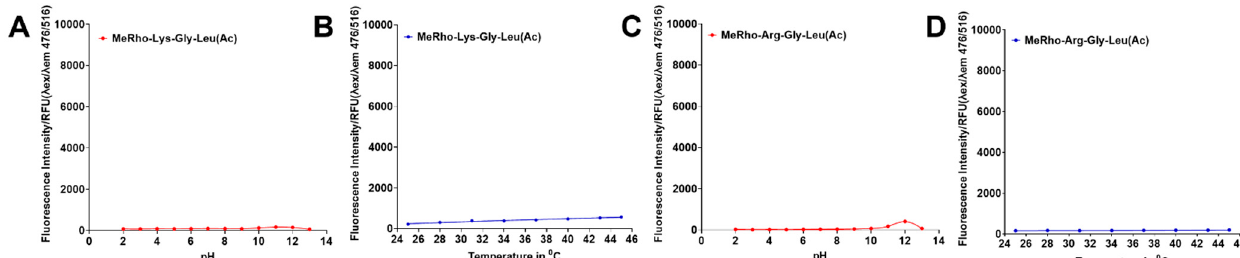
Figure 4. Stability of peptide linkages in fluorogenic peptide substrates (1 µM). ( A ) Effect of variation in pH from 2 to 13 at 30 °C on the stability of MeRho-Lys-Gly-Leu(Ac); ( B ) Effect of variation in temperature (25, 28, 31, 34, 37, 40,43, and 45 °C) in HEPES buffer (50 mM, pH 8.3) on the stability of MeRho-Lys-Gly-Leu(Ac); ( C ) Effect of variation in pH from 2 to 13 at 30 °C on the stability of MeRho-Arg-Gly-Leu(Ac); ( D ) Effect of variation in temperature (25, 28, 31, 34, 37, 40, 43, and 45 °C) on the stability of MeRho-Arg-Gly-Leu in HEPES buffer (50 mM, pH 8.3).